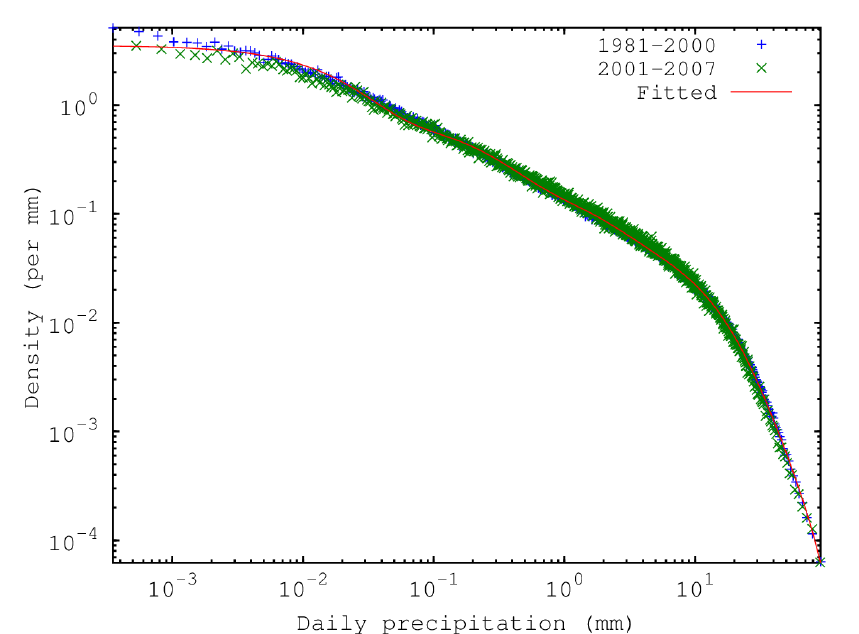
Figure 5. Empirical probability density for APHRODITE daily precipitation amount at the 0.25 ◦ grid scale (conditional on occurrence) for the region 26 ◦ –31 ◦ N, 79 ◦ –89 ◦ E and for two time periods, compared with a hyperexponential distribution fit only to the 1981–2000 data.